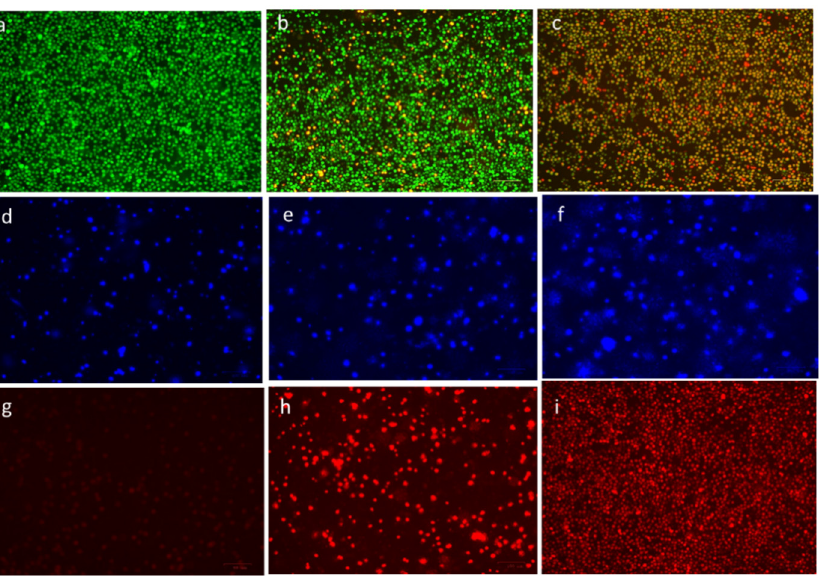
Figure 8. Detection of apoptosis through fluorescence microscopy in cells after treatment with CuO- TiO 2 -chitosan-escin nanocomposites. In vitro treatment with nanocomposites (7 and 14 µg/mL) was carried out for 24 h in MOLT-4 cells. AO/PI was used to stain the cells on the top panels; DAPI was used for the middle panel, and propidium iodide (PI) was used for the lower panel. In the panels on the right, untreated cells served as controls ( a , d , g ), and the middle panels ( b , e , h ) were treated with Cuo-TiO 2 -chitosan-escin nanocomposites (7 µg/mL). Left panel samples ( c , f , i ) were treated with Cuo-TiO 2 -chitosan-escin nanocomposites (14 µg/mL). These images were obtained at 20× mag- nification; the experiments were conducted in triplicates; the scale bar was set to 100 µm. The chromatin condensation that takes place during apoptosis can be used to identify apoptotic cells [44,45]. When stained with DAPI, condensed chromatin in nuclei increases the maximum intensity of DAPI pixels. Chromatin condensation also diminishes the size of the nucleus and, thus, the nucleus area. The cells treated with CuO-TiO 2 -chitosan-escin